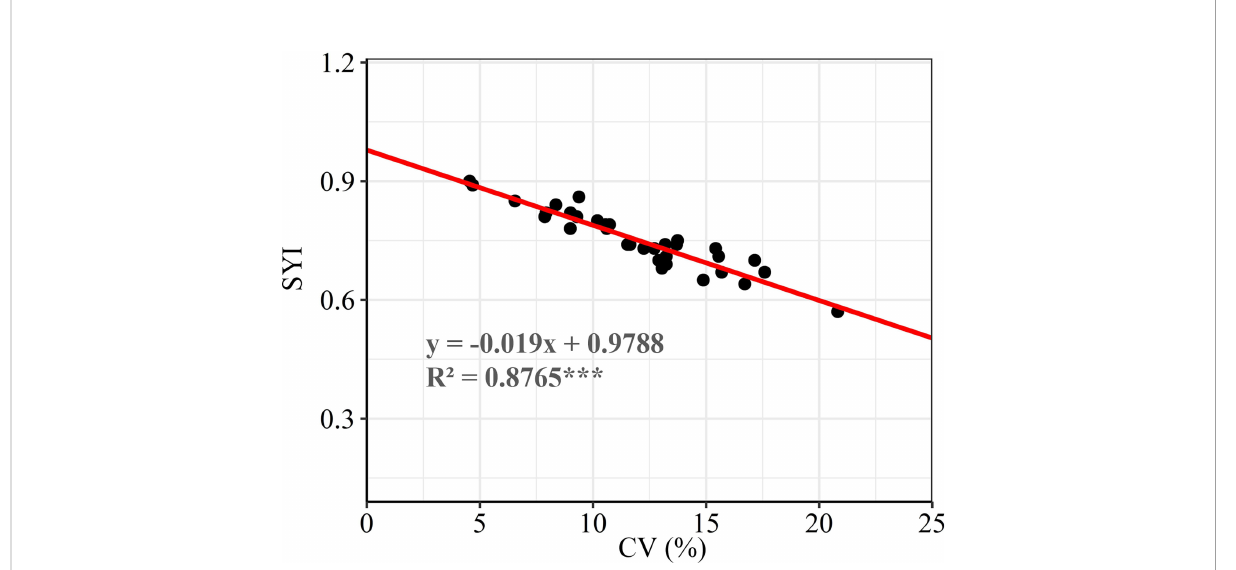
FIGURE 2 Correlation analysis between SYI and CV. *** means signi fi cant at the P<0.001